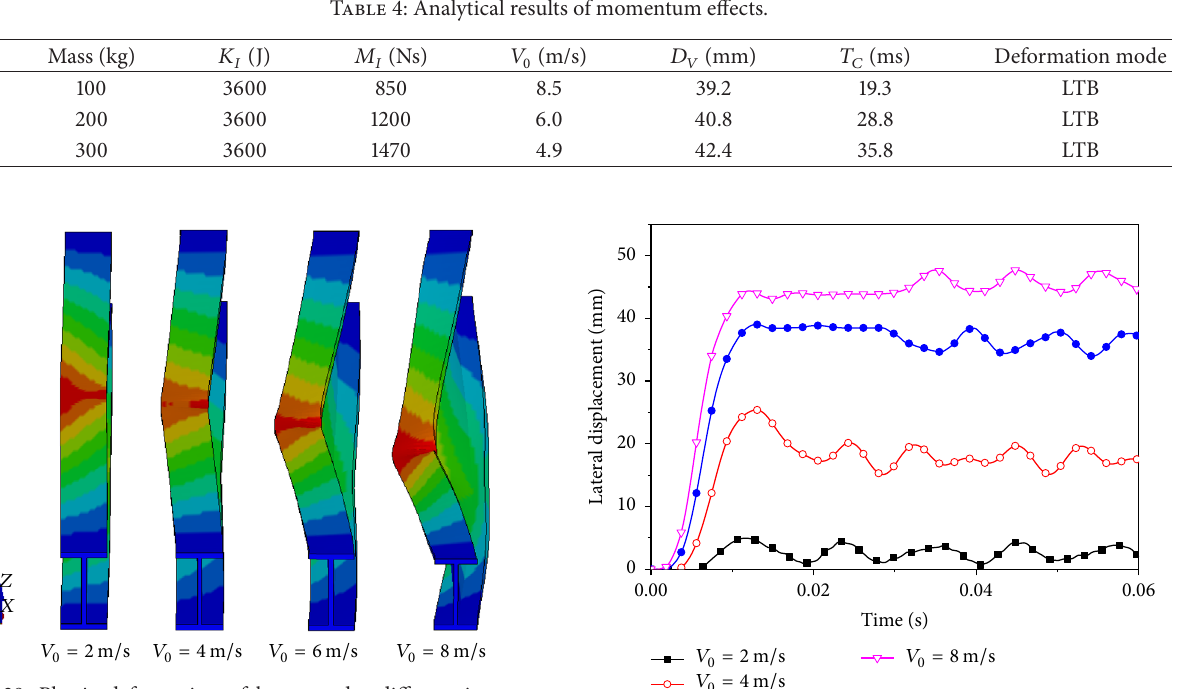
Figure 28: Plastic deformation of beam under different impact velocities.